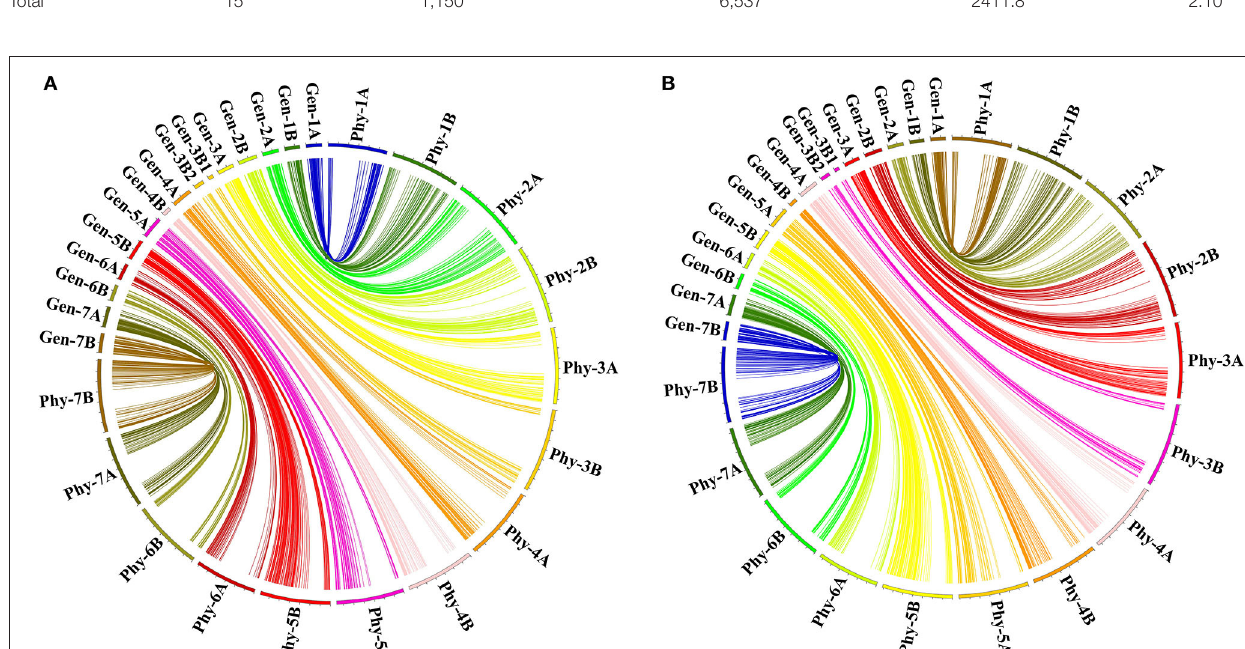
FIGURE 2 | The syntenic relationships between the genetic and physical maps of bin markers. Gen-1A to Gen-7B represented the 15 chromosomal genetic maps used in the current study; Phy-1A to Phy-7B represented the 14 chromosomal physical maps of (A) durum wheat and (B) wild emmer genomes.